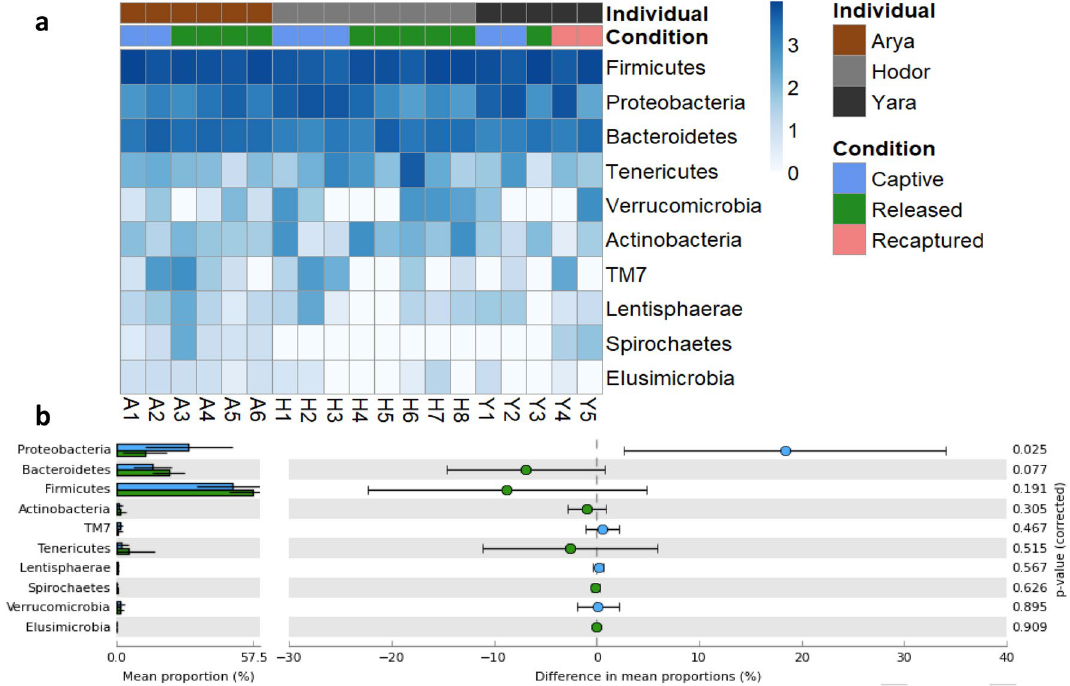
Figure 4. ( a ) Heatmap showing the logarithm of the abundance of bacterial phylum found in fecal samples from different conditions. Samples were sorted by individual, and within individual by time. Colored boxes on top of the heatmap indicate the condition when the sample was taken and are grouped by individual. ( b ) Extended error bar plot with a 95% confidence interval organized by the lowest p -value showing the differences in mean proportions between captive and released individuals and its associated corrected p -value (Welch’s t-test), notice that only proteobacteria had a significant deviation in the mean